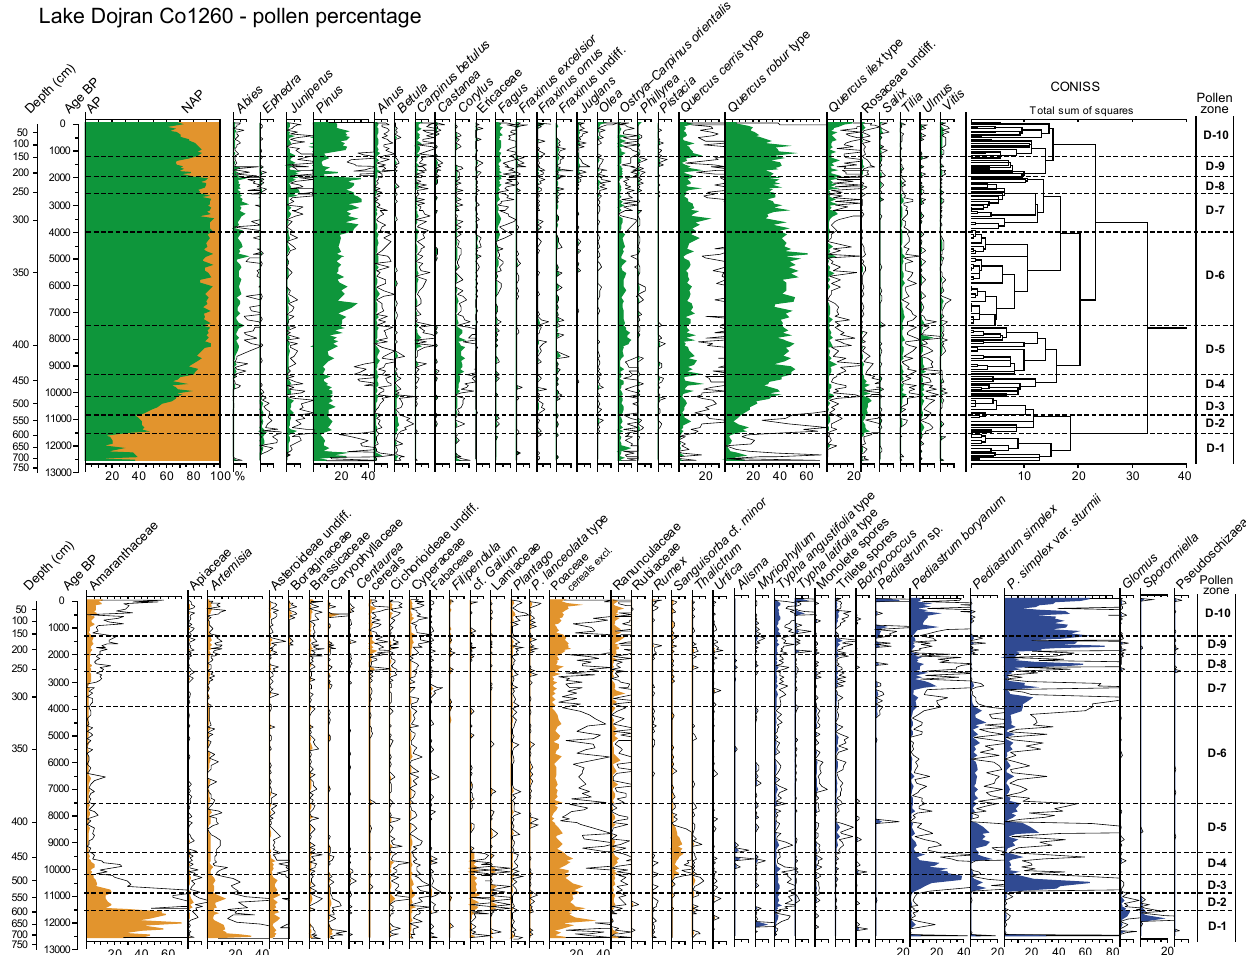
Figure 2. Pollen percentage diagrams of arboreal, non-arboreal and NPP selected taxa and CONISS. Curve magnification 5 × .